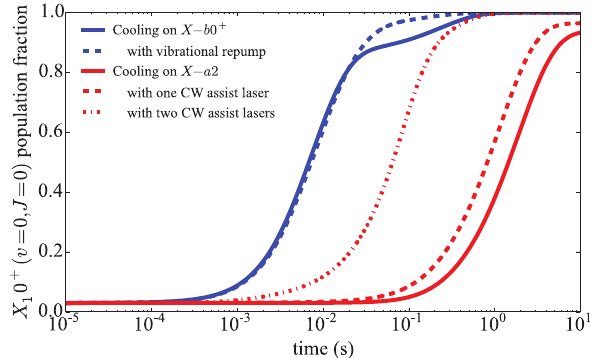
Figure 7. Simulation results for the | X 1 0 + , v = 0, J = 0 (cid:105) population versus cooling time, beginning from a 293 K thermal